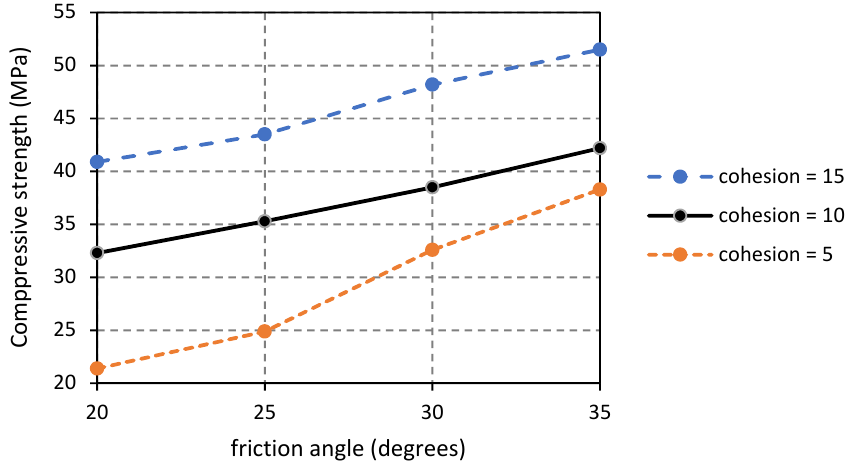
Figure 14. Compressive strength for different values of joint friction angle and joint peak cohesion (in MPa).